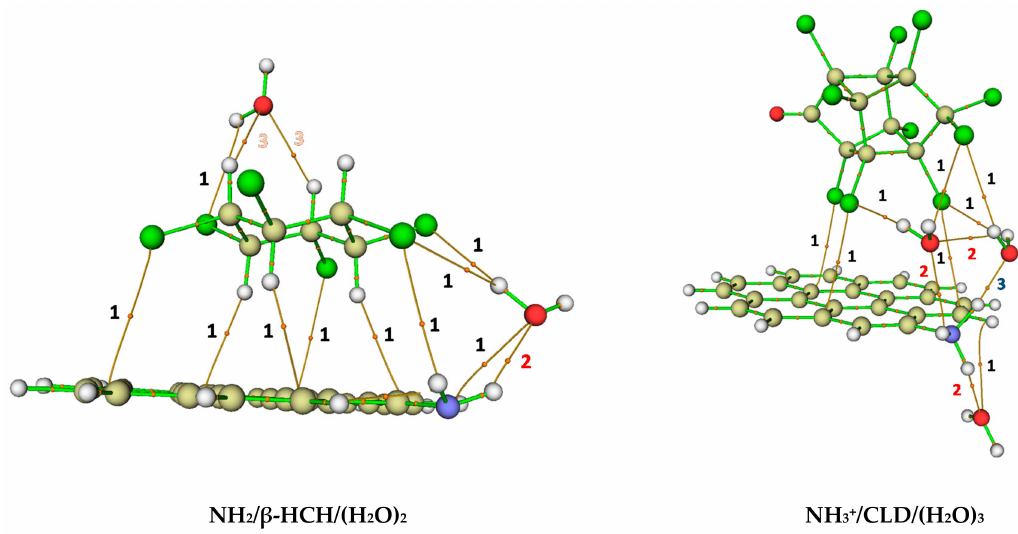
Figure 8. Interactions and bond paths obtained by QTAIM for distinctive minima structures of the systems NH 2 / 3+ /CLD/(H β -HCH/(H 2 O) 2 and NH 2 O) 3